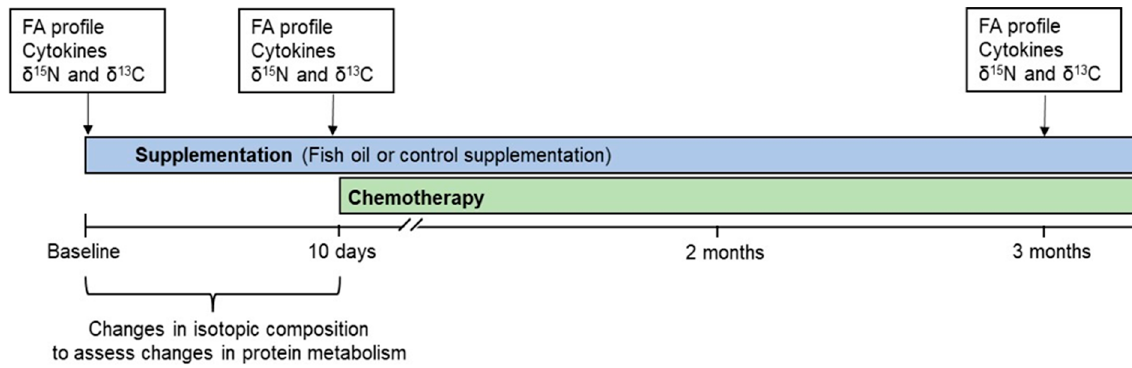
Figure 1. Study timeline. FA, fatty acid.